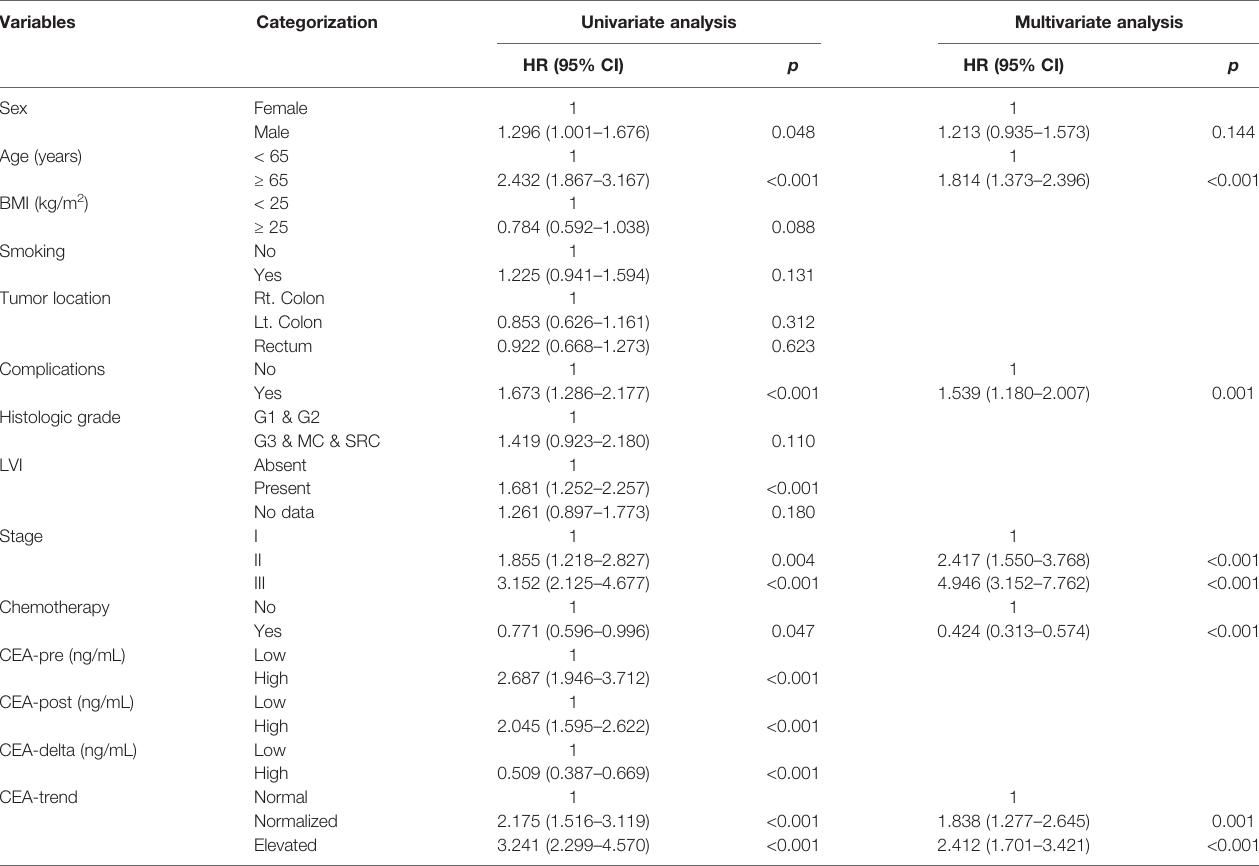
TABLE 2 | Univariate and multivariate analysis of factors associated with overall survival.